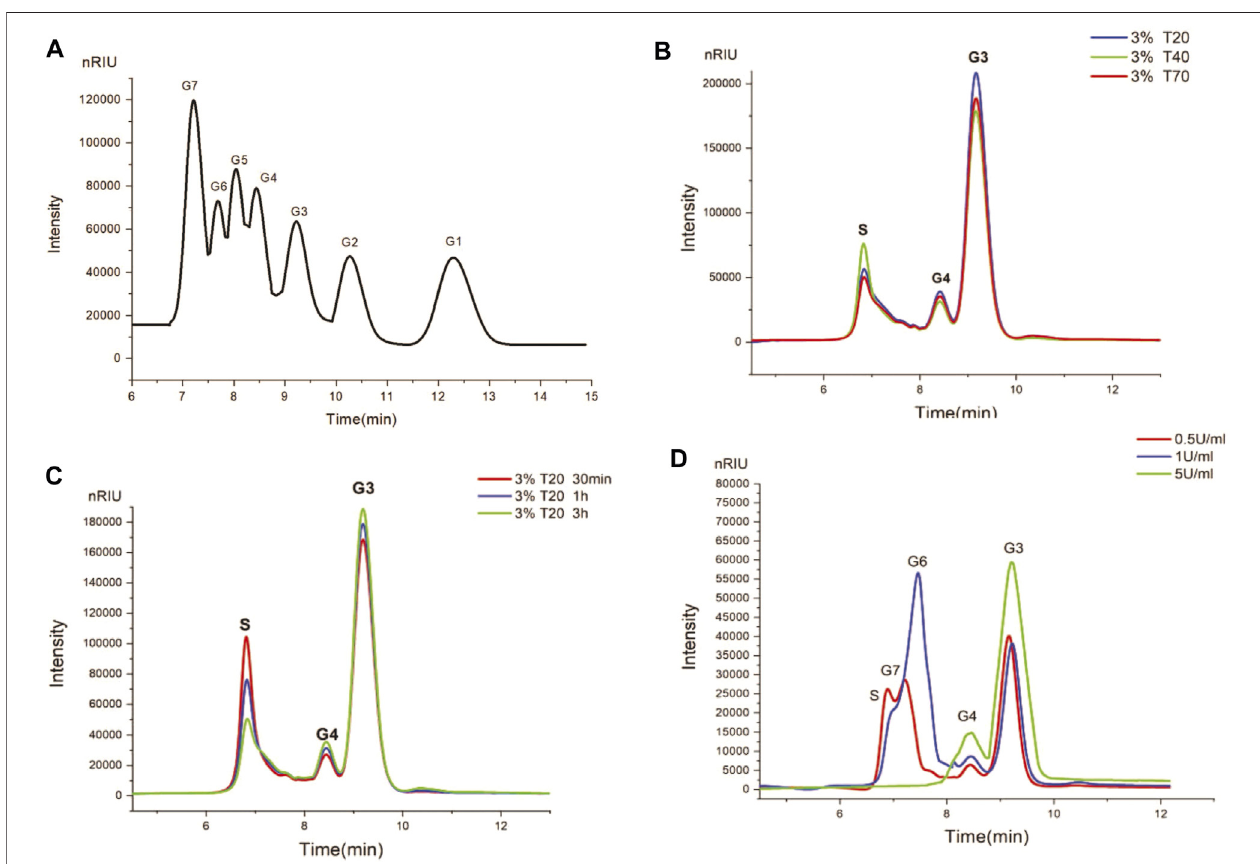
FIGURE 5 | Hydrolysates of different hydrolysis systems by HPLC. (A) standards from G1 to G7 were glucose, maltose, isomalto-triose, isomalto-tetraose, isomalto-pentaose, isomalto-hexaose, and isomalto-heptaose, respectively. (B) Hydrolysates of 3% T20, 3%T40, and 3%T70 after 1 h. (C) Hydrolysates of 3% T20 after 30 min, 1 h, and 3 h. (D) Hydrolysates of 0.5%T20 by different dextranase activity (0.5, 1, and 5 U/ml).